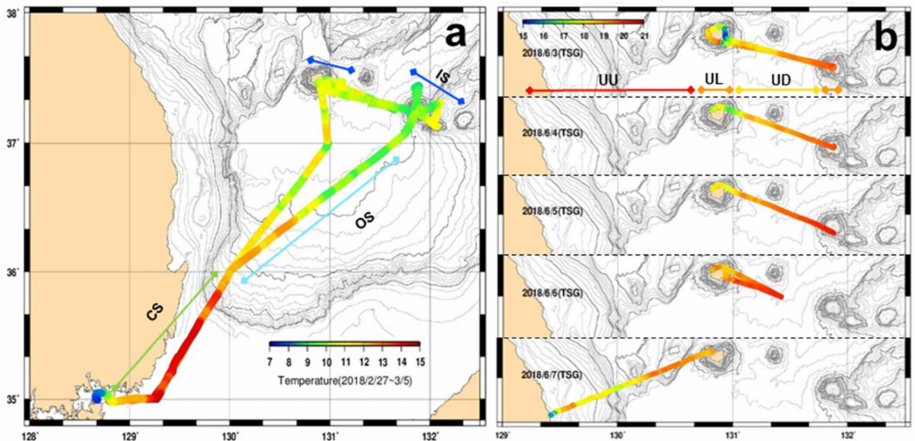
Figure 2. Horizontal distribution of real-time surface water temperature determined using a ther- mosalinograph (TSG) that was attached to the ship during early spring ( a , 27 February to 5 March) and late spring ( b , 3 to 7 June). Temperatures had different scale ranges for each